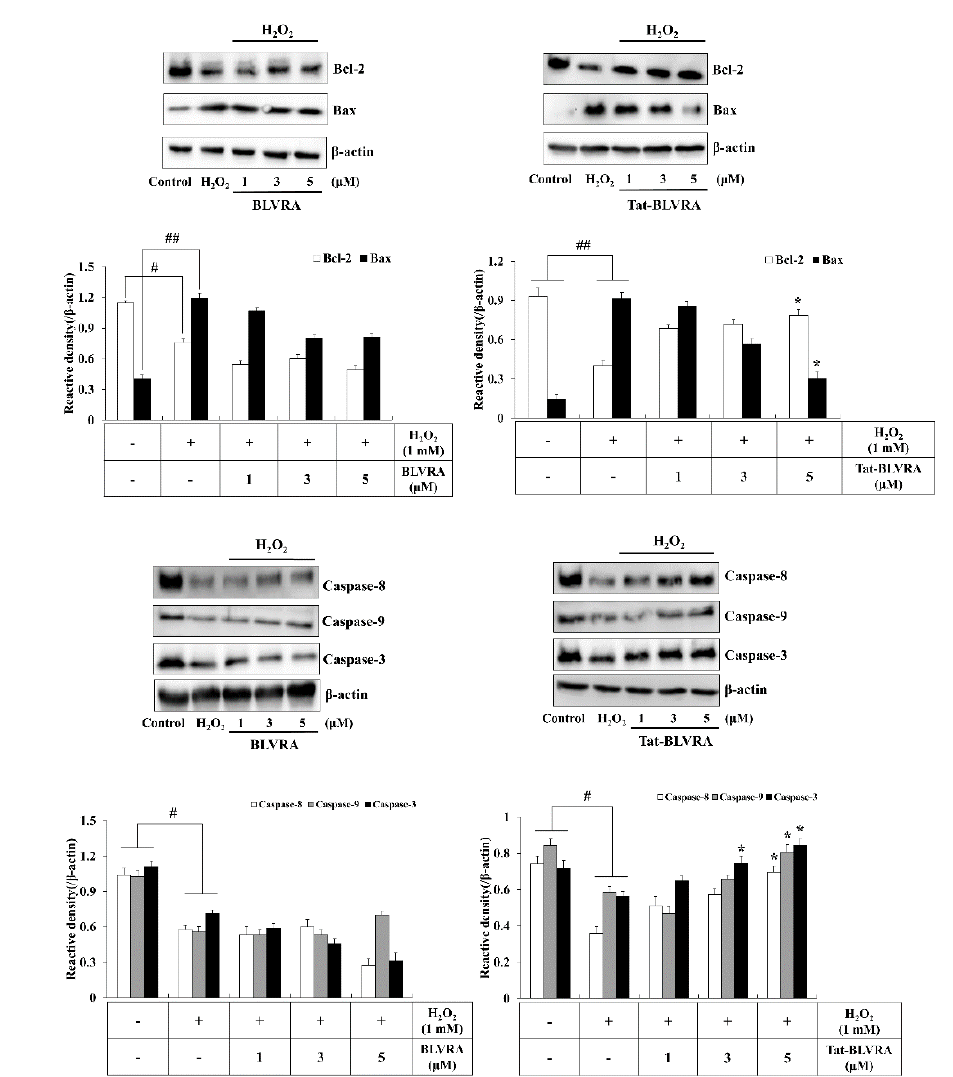
Figure 4. Effect of Tat-BLVRA protein on the expression of Bcl-2, Bax, and caspase cascades in HT-22 cells. The cells were treated with Tat-BLVRA protein and then exposed to H 2 O 2 . The expression of Bcl-2 and Bax as well as caspase cascade levels were measured by Western blotting and band intensity was measured by a densitometer. The bars in the figures represent the mean ± SEM obtained from 3 independent experiments. * p < 0.05 compared to cells treated only with H 2 O 2 . # p < 0.05 and ## p < 0.01 compared to the untreated control cells.